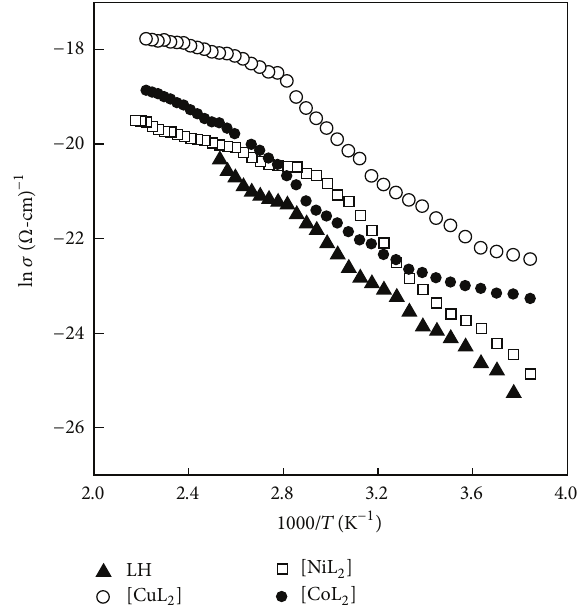
Figure 4: Temperature dependence of the electrical conductivity of synthesized ligand and its